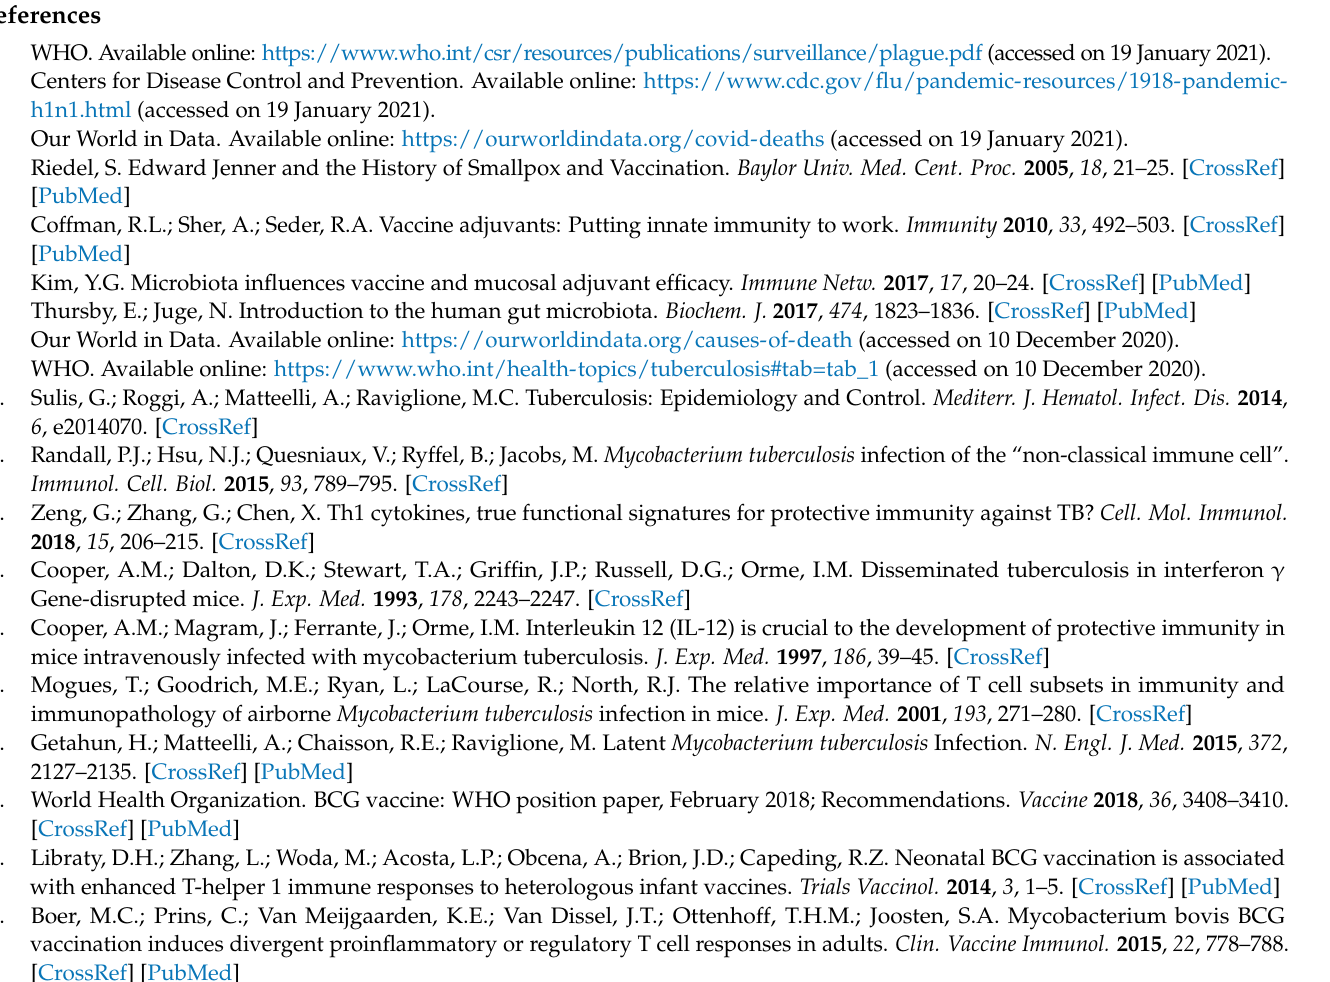
figure preparation, J.U.; writing—original draft preparation, K.Y.; writing—review and editing, M.A. and Y.-G.K.; project supervision, Y.-G.K. All authors have read and agreed to the published version of the